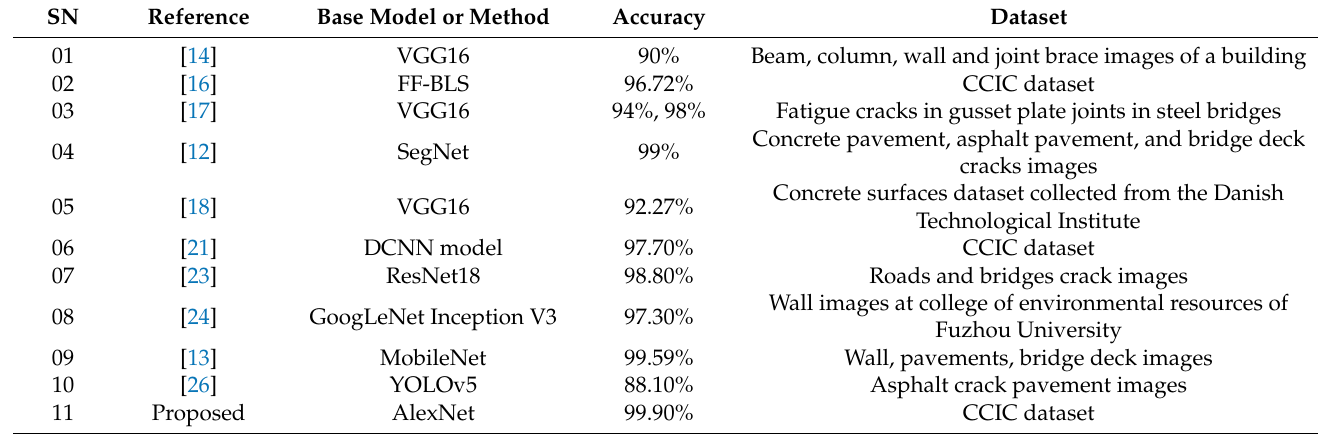
Table 8. Summary of publications using CNN-based transfer learning techniques for cracks